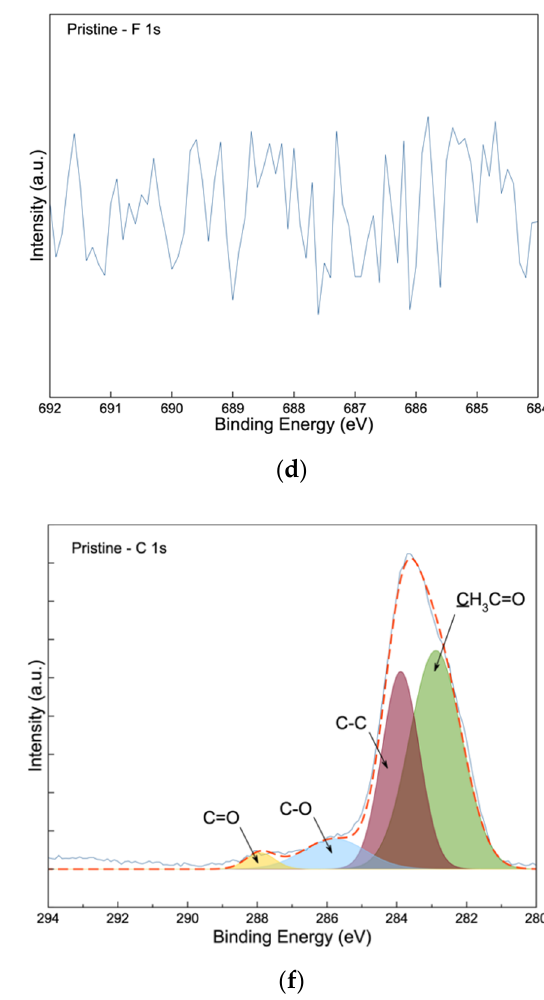
Figure 3. XPS spectra of ( a ) Si 2p, ( b ) N 1s, ( c ) Li 1s, ( d ) F 1s, ( e ) O 1s, and ( f ) C 1s of pristine Si 3 N 4 @Si@Cu anodes.